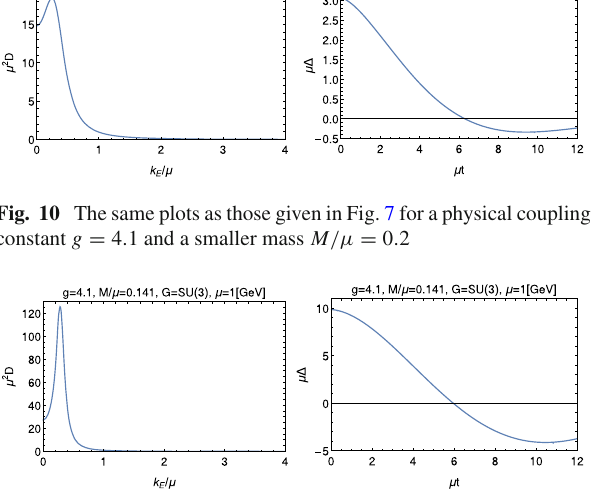
Fig. 11 The same plots as those given in Fig. 7 for a physical coupling constant g = 4 . 1 and a further smaller mass M /μ = 0 . 141